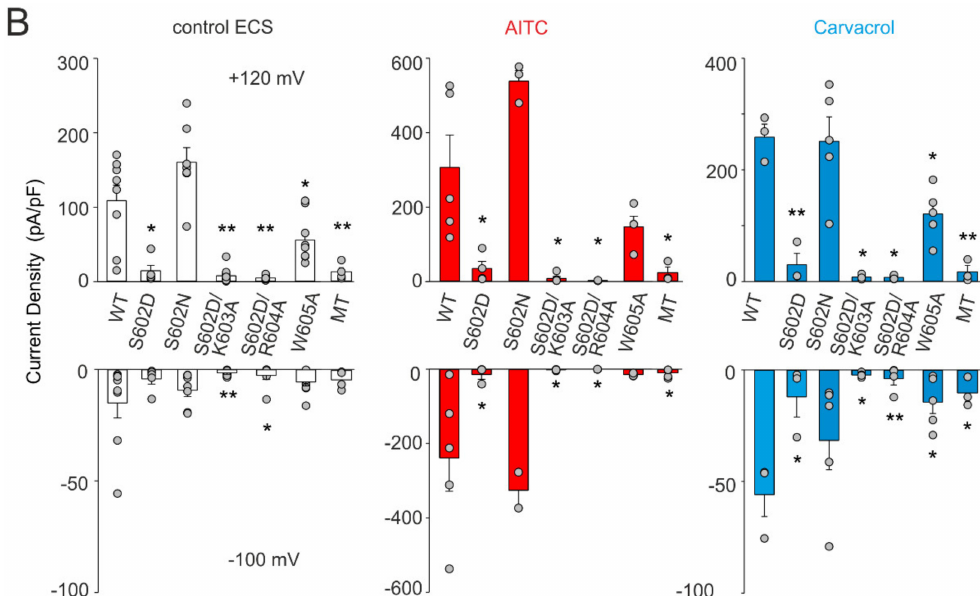
Figure 3. E ff ects of mutations at Ser602 and contiguous residues on TRPA1 responses. ( A ) Time course of whole-cell current responses induced by voltage ramp ( − 100 mV, + 120 mV; protocol shown in Figure 2B), applied in the presence of extracellular control solution (ECS), allyl isothiocyanate (AITC; 100 µ M) or carvacrol (Carv; 50 µ M). ( B ) Maximal amplitude of currents measured from recordings such as shown in A for indicated mutants ( n = 3–10) and for mock-transfected cells (MT). The amplitudes were measured at times indicated by the colored points shown for the wild-type (WT) in A. The error bars represent the standard error of the mean. * p < 0.05; ** p < 0.005; Student’s t